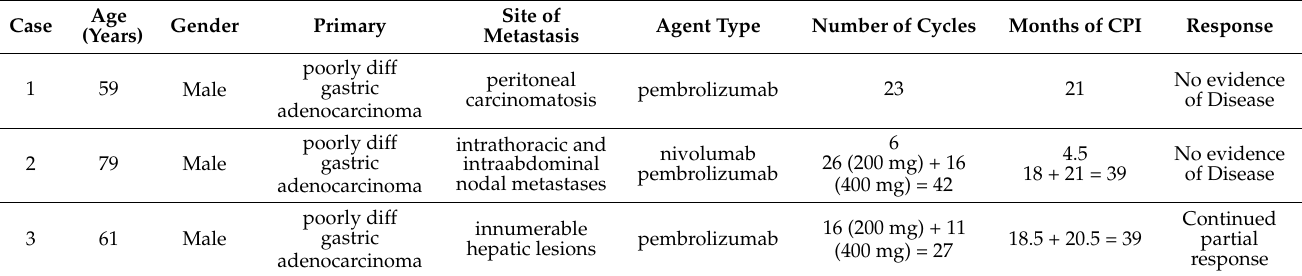
Table 1. Patient characteristics, cancer type and